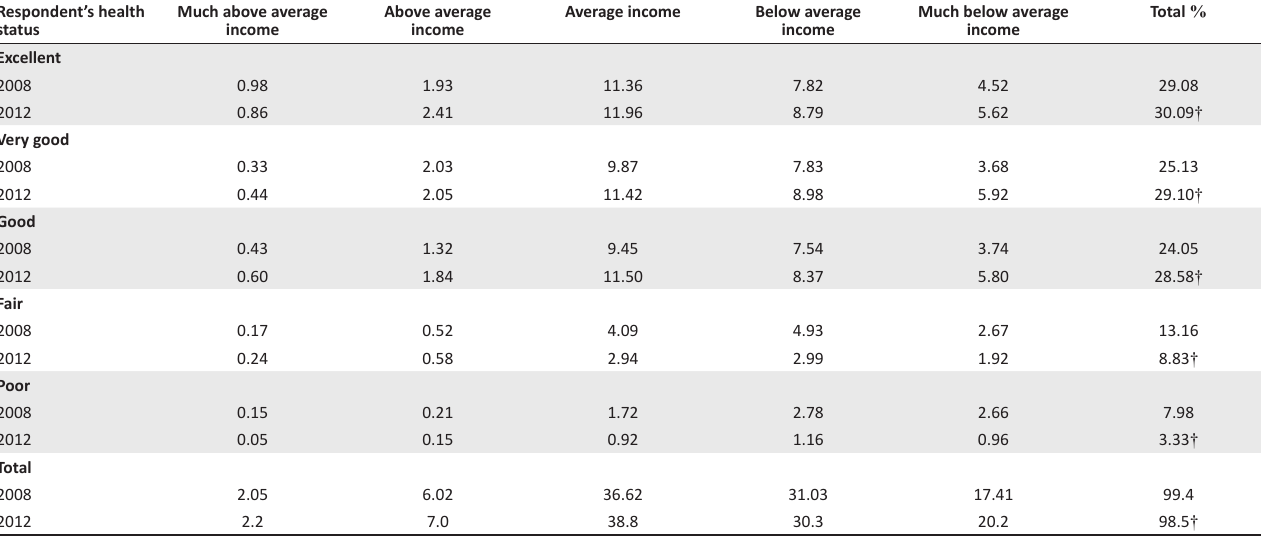
TABLE 3: Comparison between 2008 and 2012 surveys – Health status and income classification (individual level – adult). Respondent’s health status